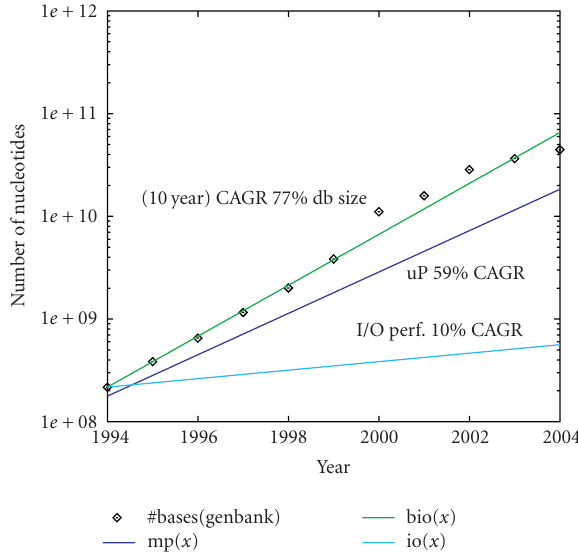
Figure 2: Compound annual growth rate of problem size, single processor performance, and I/O subsystem